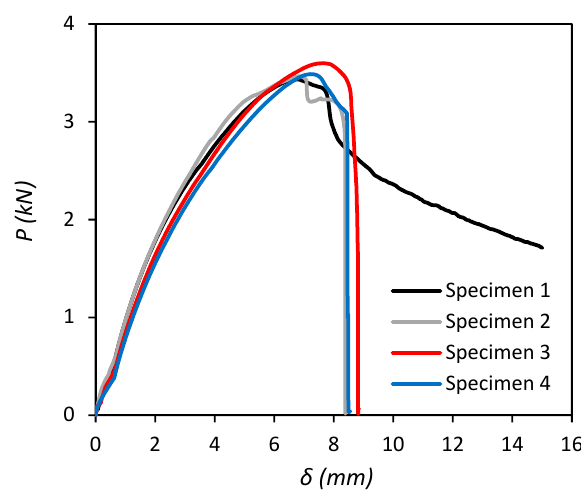
Figure 9. Load displacement responses for tensile lap-shear tests.